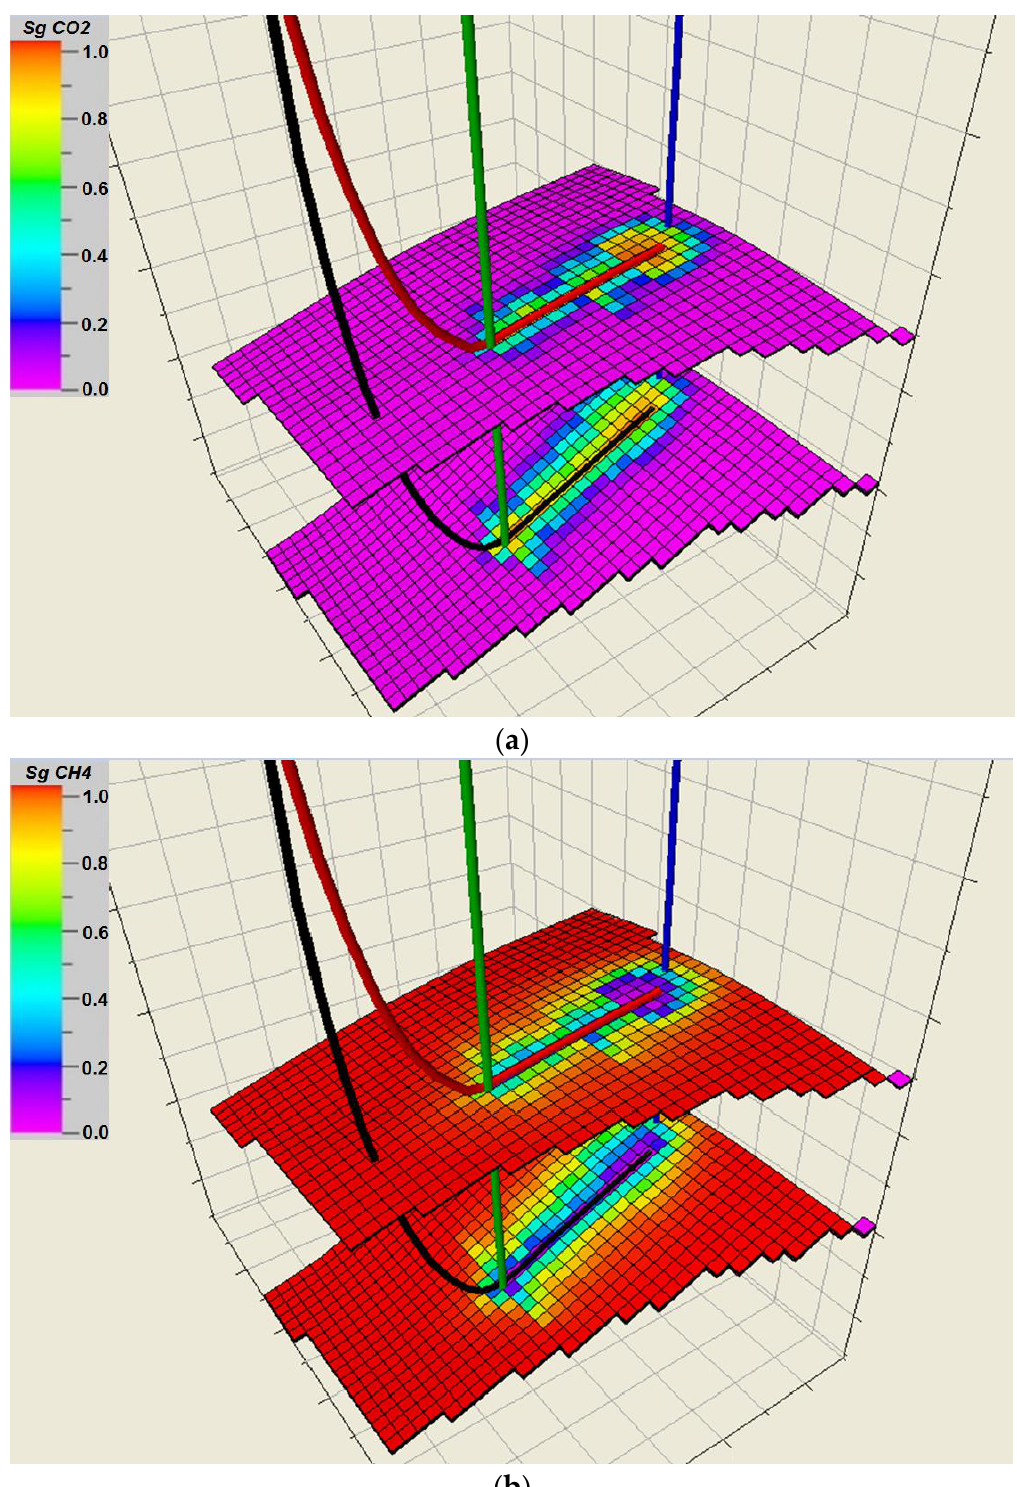
Figure 9. Changes in gas saturation- Sg : ( a ) CO 2 and ( b ) CH 4 in fractures after 1 year of CO 2 injection (mole fractions of gases in fractures).